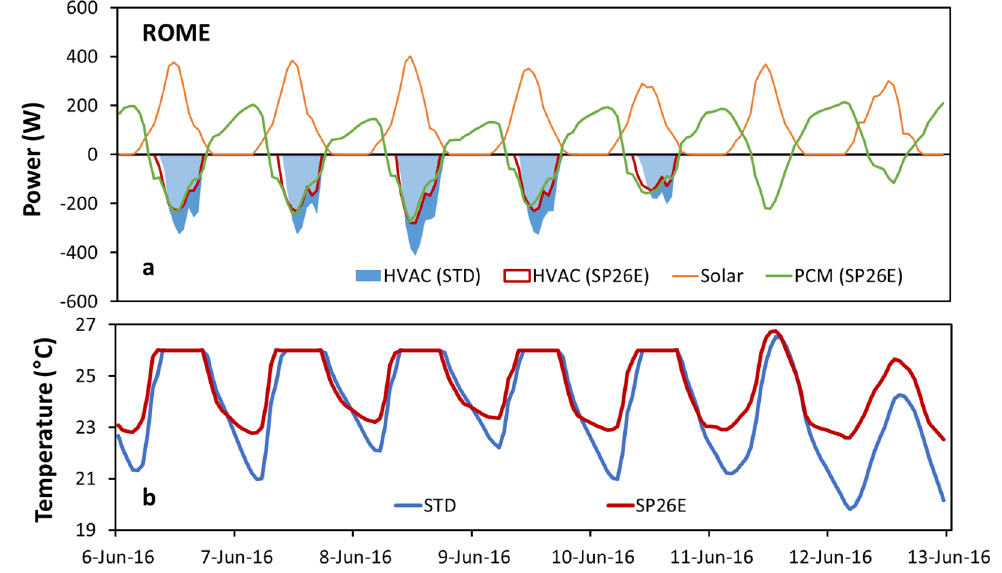
Figure 14. PCM acting in cooling mode. Example of a week of June in Rome: ( a ) heat balance; ( b ) inside air temperature for STD and SP26E.